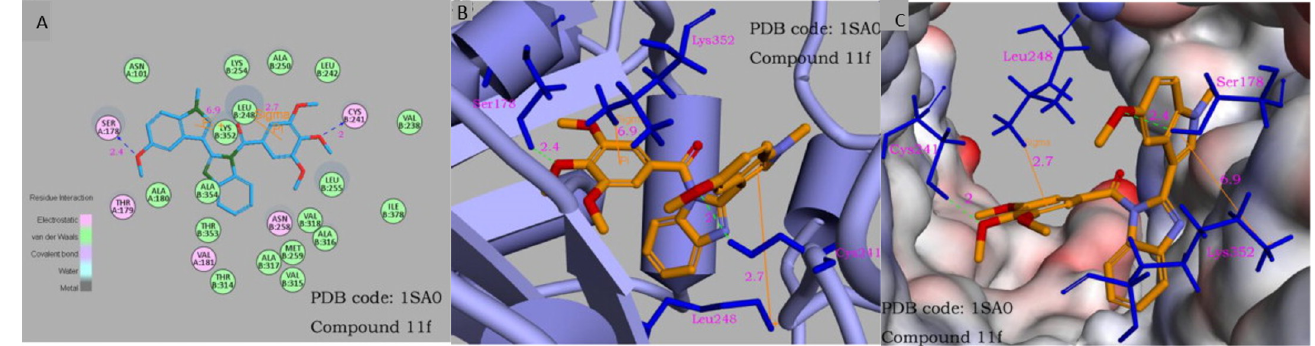
Figure 12. Interaction between tubulin and chemical 11f’s active conformation. ( A ) A 2D schematic depicts the interaction of compound 11f with the colchicine binding site. The H-bond (blue arrows) is shown as dotted arrows, whereas the π -cation interaction is shown as orange lines. ( B ) A three- dimensional illustration depicts the interaction of compound 11f with the colchicine binding site. For convenience, only interacting residues are shown. Orange lines represent the p-cation interaction, while dot arrows represent the H-bond (green arrows) ( C ).